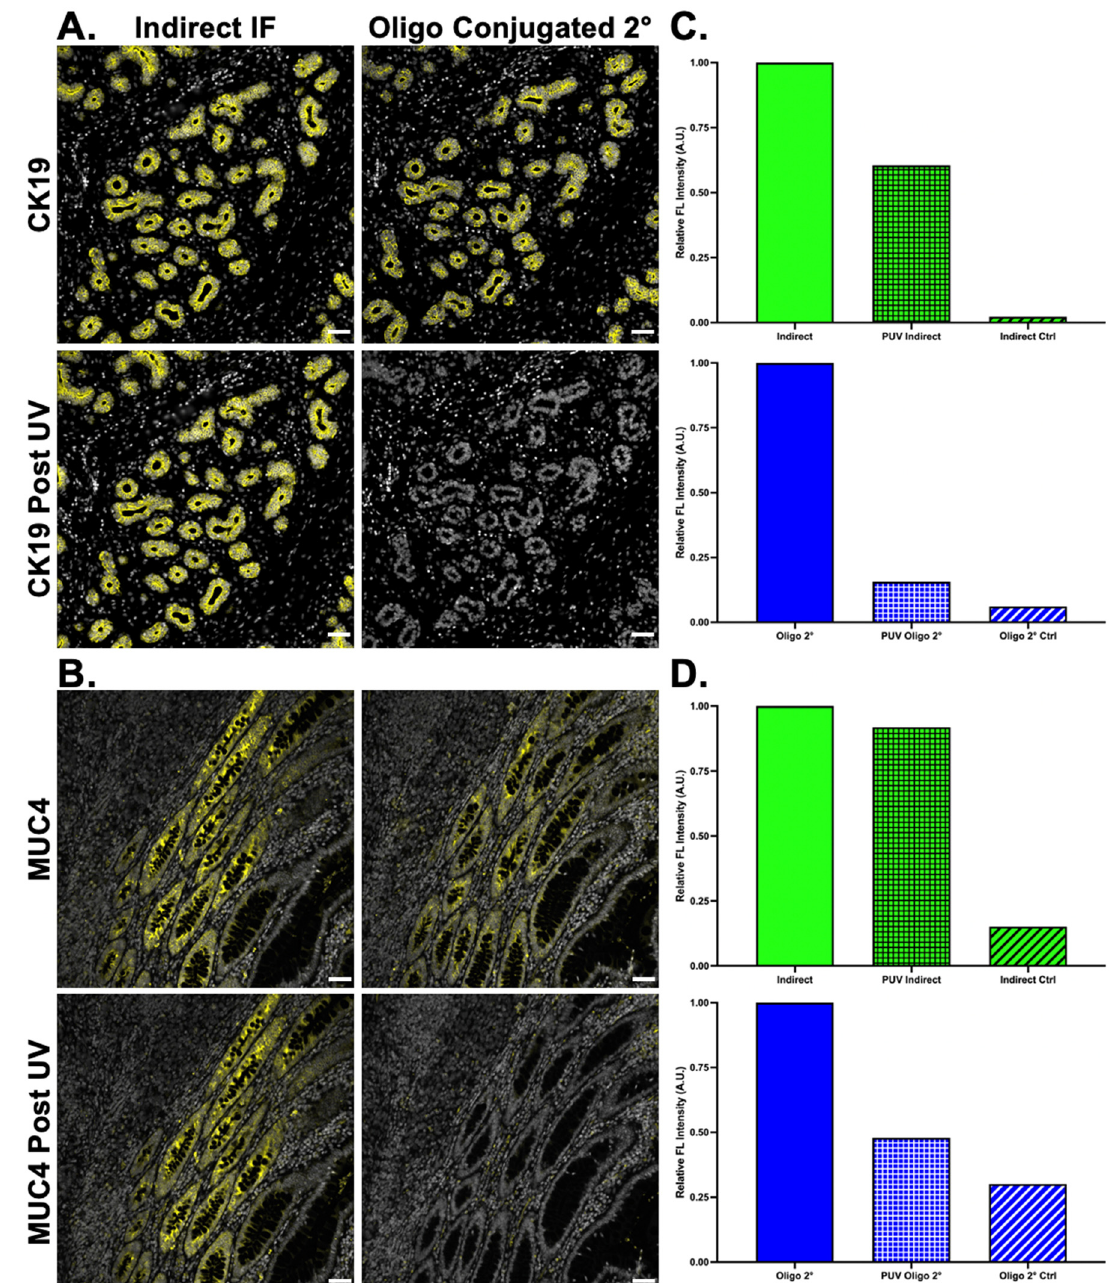
Figure 6. Oligonucleotide conjugation to secondary antibodies. Secondary antibodies were conju- gated to unique DS and used to stain ( A ) CK19 (yellow) and ( B ) MUC-4 (yellow) in tissues with DAPI (white) staining to show tissue patterns. The oligonucleotide-conjugated secondary antibody